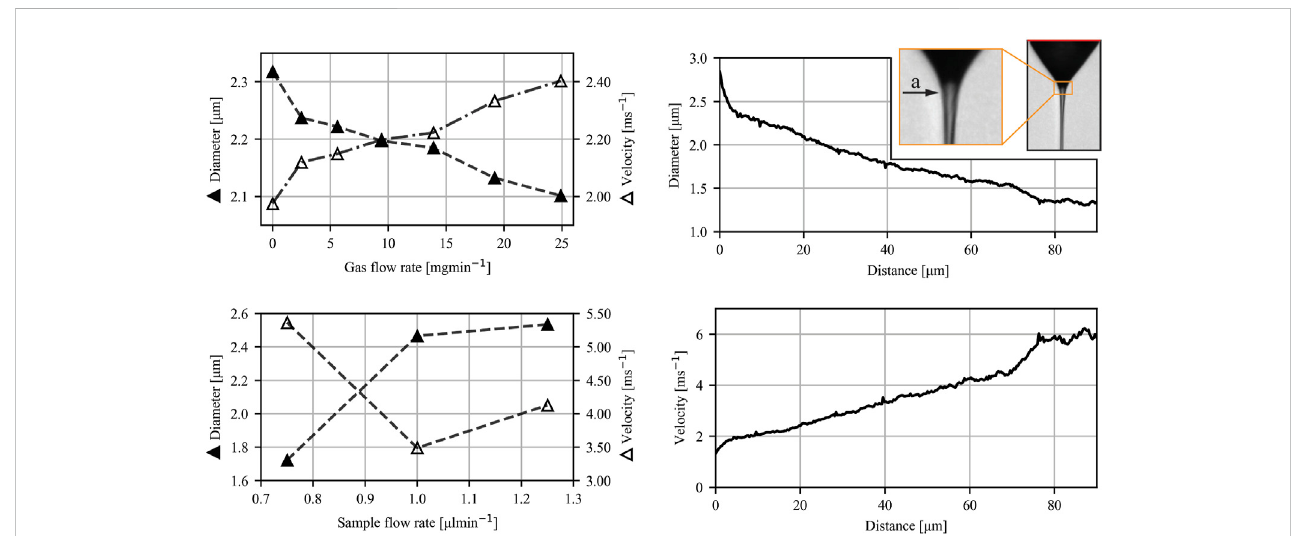
FIGURE 8 Diameter and velocity pro fi les for vacuum conditions. Figures on the left show the in fl uence of GFR and SFR on jet diameter and velocity 50 μ m downstreamofthetransitionfromthemeniscustothejet(denotedbyanarrow(a)intheinsertontheright).The fi guresontherightshowatypicaldiameterof ajet(solid triangle) andits velocitypro fi le (open triangle) invacuum conditions.The dimensionlesslength is 0.405for thelowest GFR values and 0.306for the highest GFR values. EP = 6 kV for all cases.